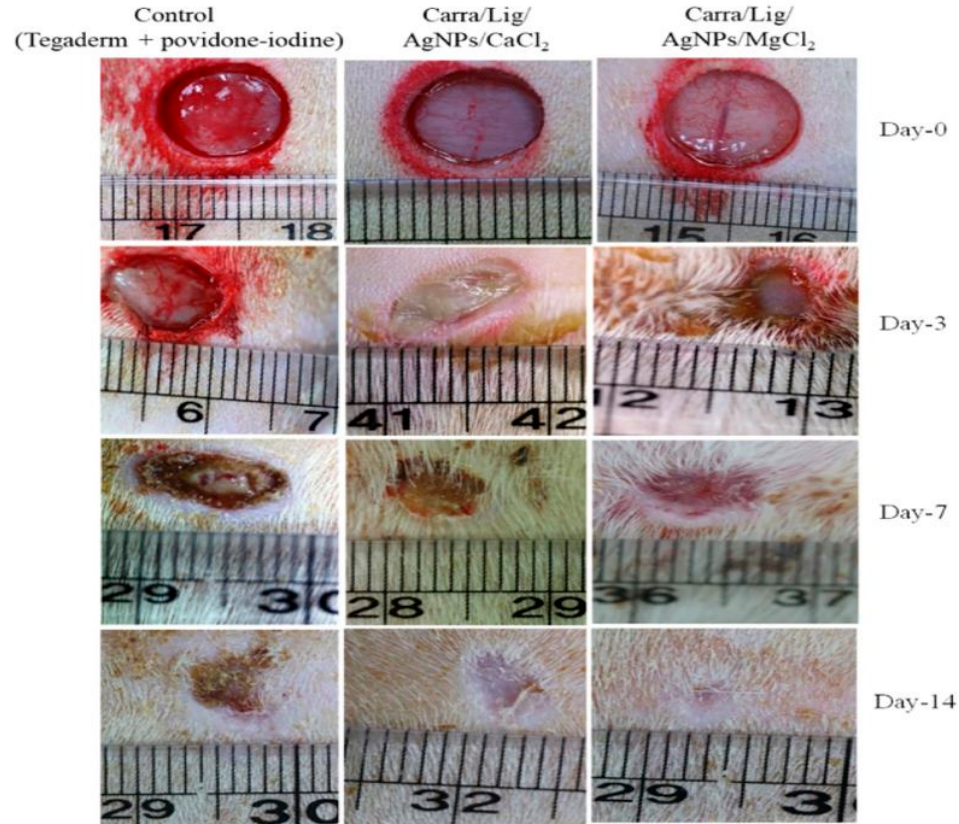
Figure 5. Wound healing effect of carrageenan-based nanocomposite hydrogels evaluated by the apparent photographs, which are showing wound healing progress. Reprinted with permission from [99], copyright 2020 Elsevier.